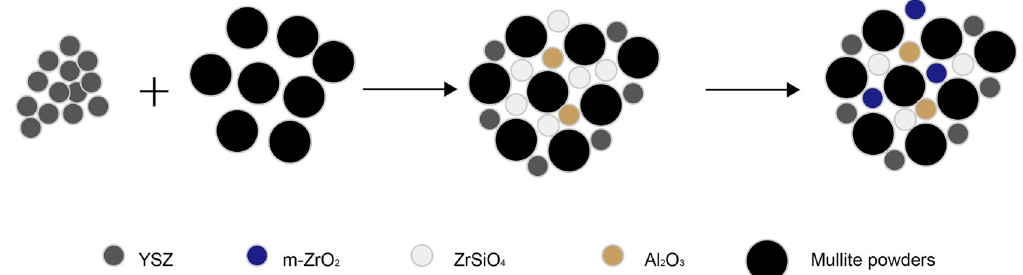
Fig. 9 Schematic diagram of sintering process for mullite particles doped with YSZ.